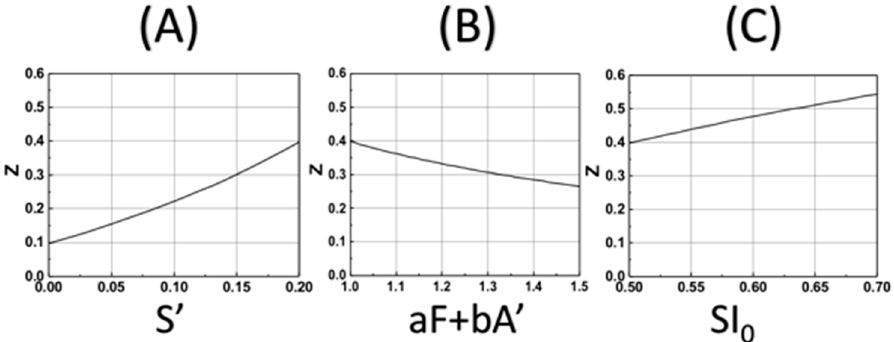
Figure 4. The calculated temperature of monomer versus G = aF + bA’ based on Equation (15) at various sample depth z = (0, 0.4, 0.5, 0.6) cm, for curves (1, 2, 3, 4), at t = 200 s.